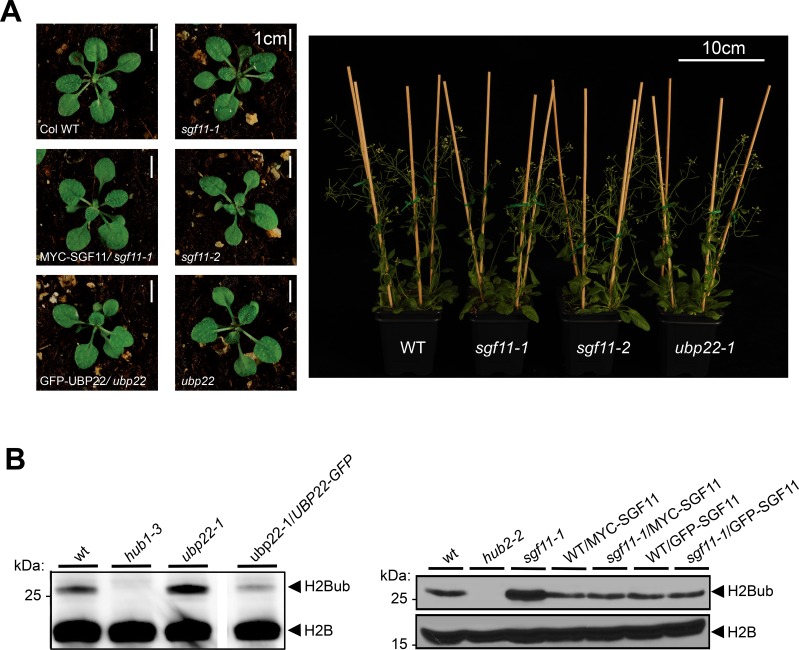
Functional analysis of the ubp22-1, sgf11-1 and sgf11-2 mutant lines.(A) Homozygous ubp22-1, sgf11-1 and sgf11-2 plant lines display no obvious developmental phenotype under standard laboratory growth conditions. Representative phenotype of seedling and adult plants bearing SGF11 or UBP22 loss-of-function are shown. (B) H2Bub over-accumulation in the ubp22-1 and sgf11-1 line is suppressed by stable re-introduction of a functional UBP22 or SGF11 coding sequence, respectively. Immunoblots of light-grown seedlings protein extracts were performed using the indicated antibodies.